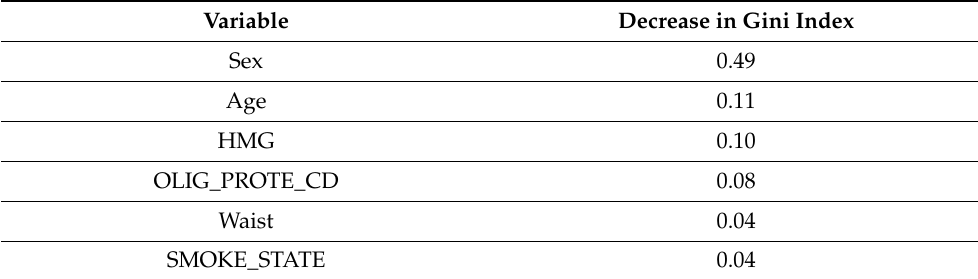
Table 6. Factors important in predicting Creatinine